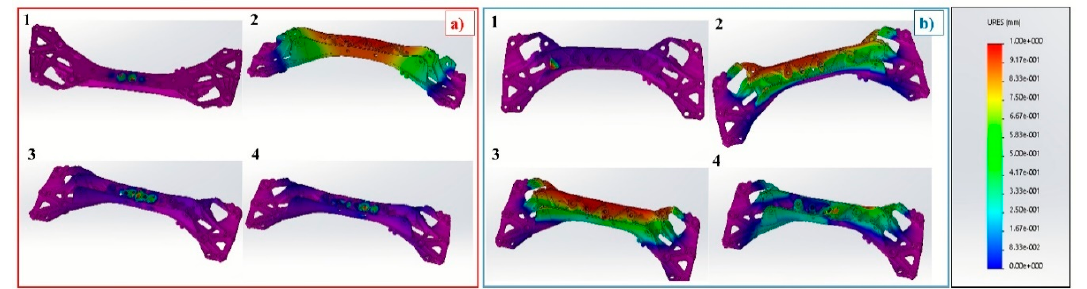
Figure 8. Displacement trend for the first four deformations for new geometry: ( a ) load case 1 (F); ( b ) load case 2 (M). Table 6. Load buckling factors for two geometries and for two different external loads .